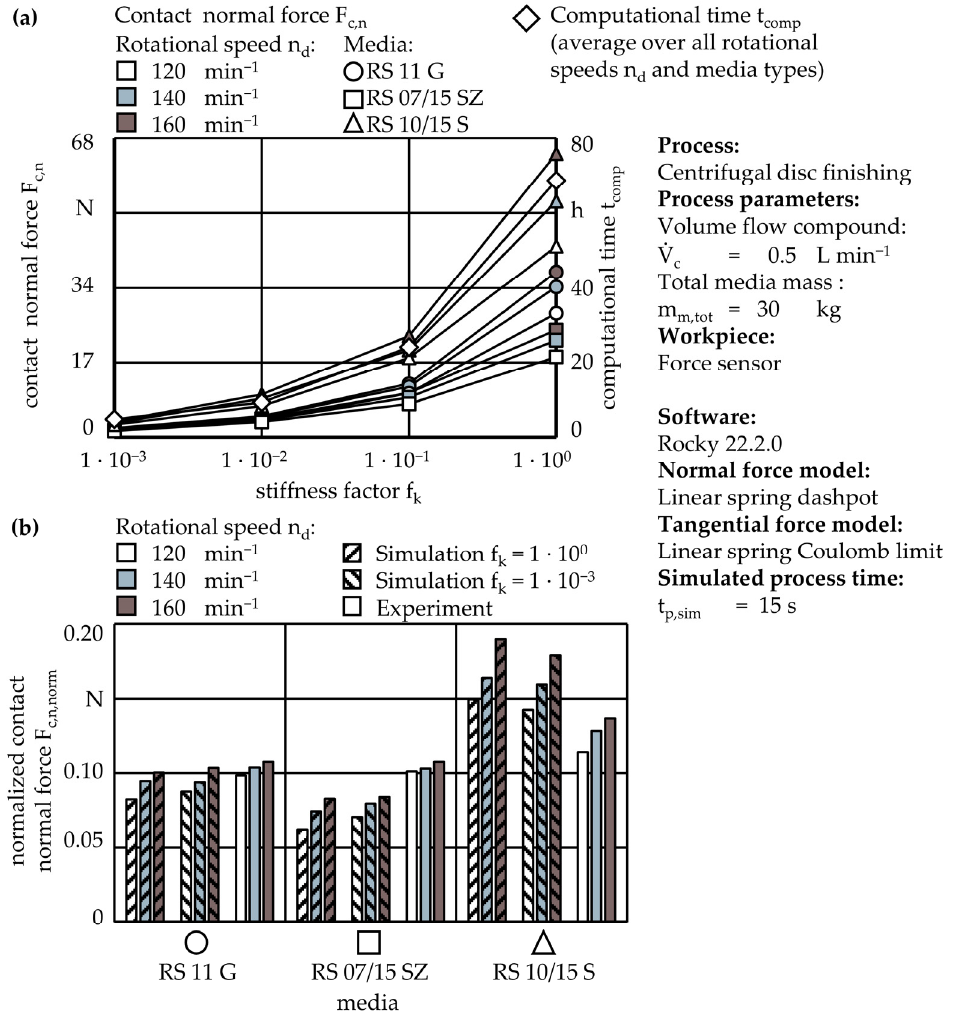
Figure 8. Simulation of contact forces: ( a ) influence of stiffness reduction on contact forces; ( b ) comparison of simulated and experimental contact forces.